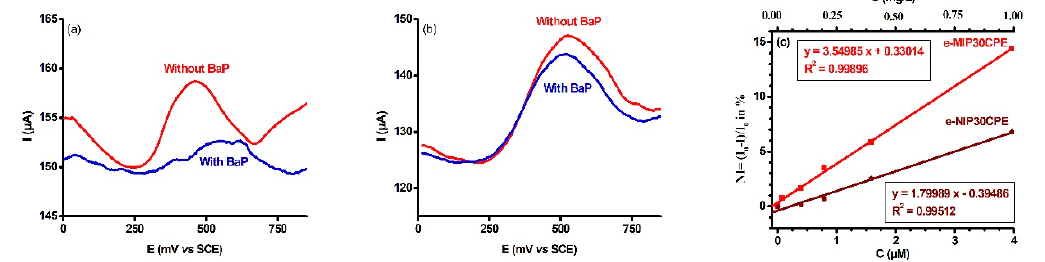
Figure 2. SWV of e-MIP-VFc-EDMA-CPE ( a ) and e-NIP-VFc-EDMA-CPE ( b ) with and without BaP after 4h. ( c ) Normalized current curves where I is the current obtained in presence of BaP and I 0 the current before target addition. In percentage in function of BaP